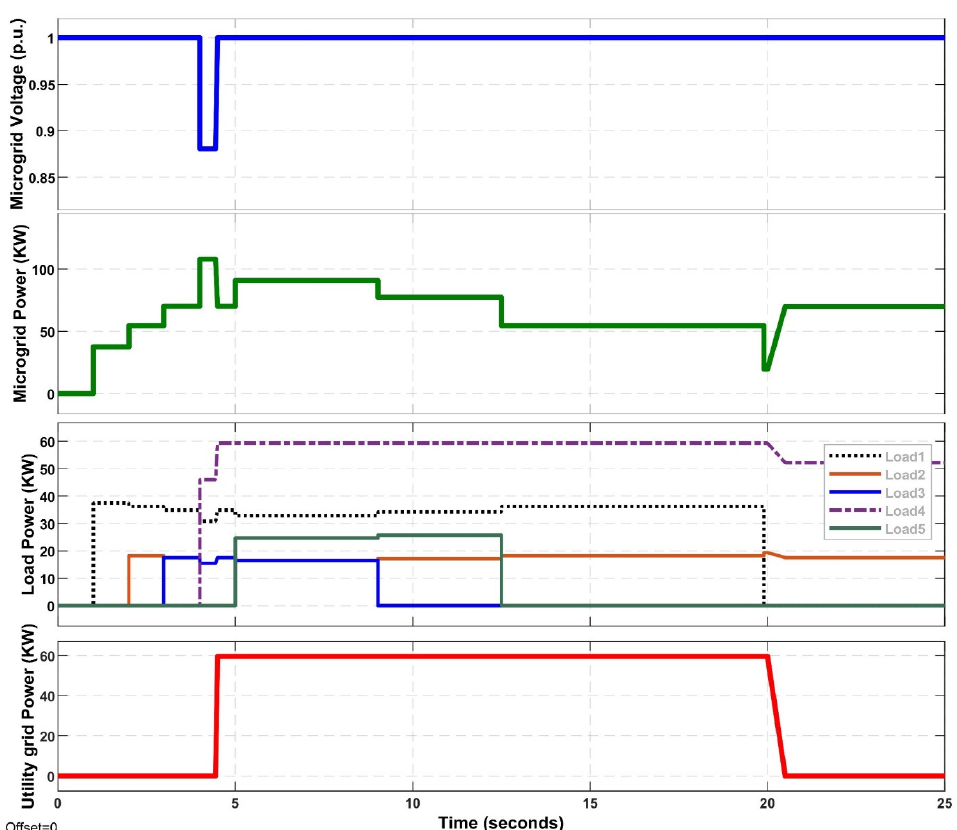
Figure 19. Change of microgrid voltage, microgrid power and utility-grid power versus time. Five non-critical loads were sequentially connected to the microgrid, a selected load (load4) was disconnected from the microgrid and momentary connected to utility grid.